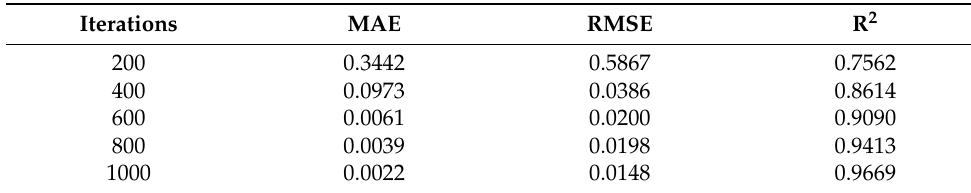
Figure 11. Comparison of LSTM Model Forecast and Real Value. ( a ) Comparison of predicted and real air temperatures over the next hour. ( b ) Comparison of predicted and true air humidity values over the next hour. ( c ) Comparison of predicted and true soil temperatures of 20 cm in the experimental area over the next hour. ( d ) Comparison of predicted and true soil moisture values for 20 cm in the experimental area over the next hour. Table 6. LSTM model performance evaluation